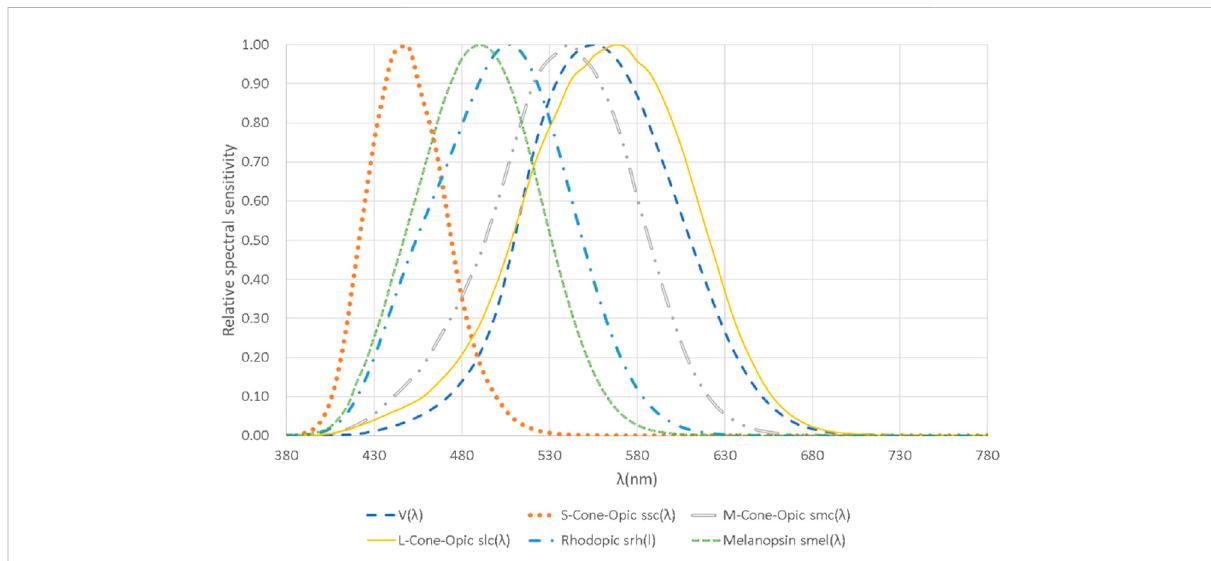
FIGURE 4 The fi ve α -opic action spectra and V( λ ) plotted against wavelength with a linear scale for the relative spectral sensitivity. Plotted on the basis of the data from CIE S